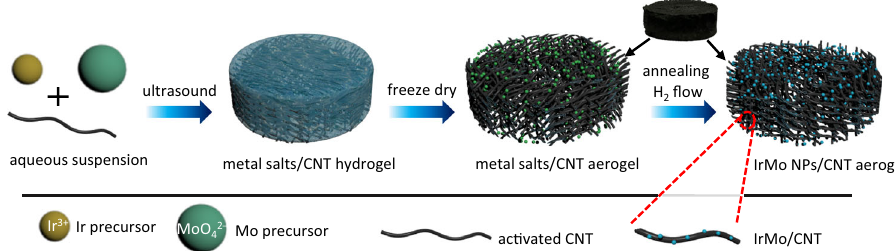
Fig. 1 | SchematicofthepreparationfortheCNT-supportedIntermetallicIrMo NPs by freeze-drying impregnation and annealing reduction. Hydrophilic groups at the activated CNT can help the formation of hydrogel during the ultra- sound treatment by the crosslinking of CNT. The water in the frozen hydrogel